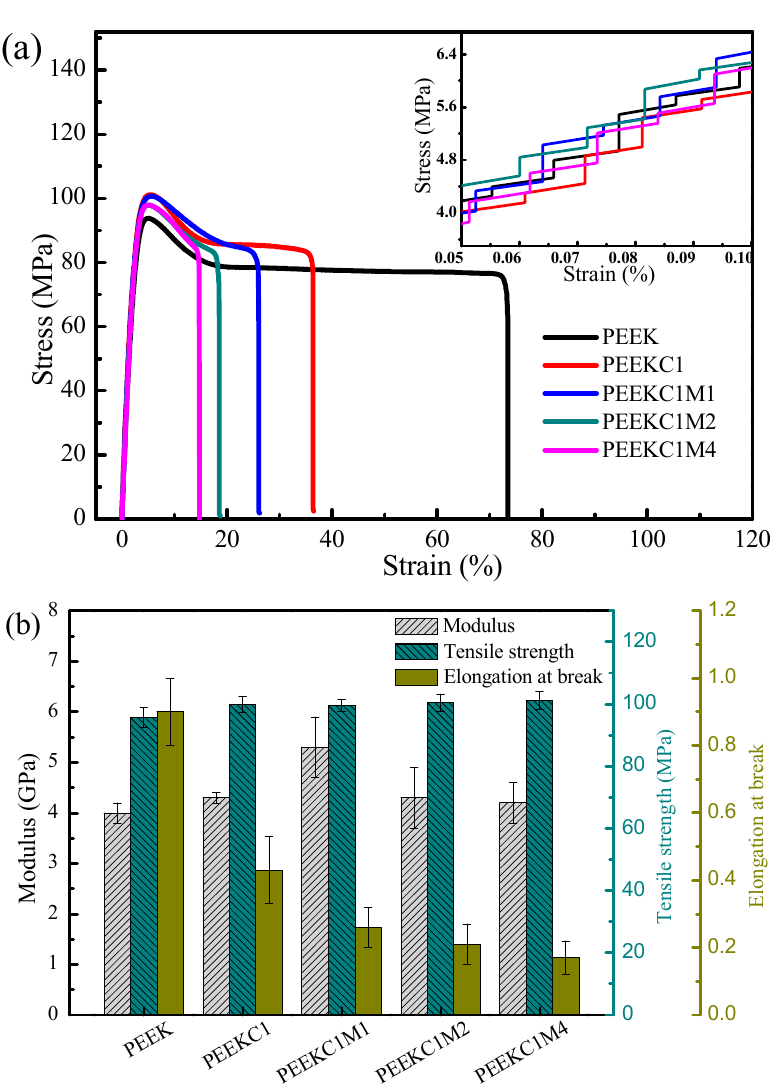
Figure 6. Typical engineering stress-strain curves of PEEK nanocomposites and the inset is the magnification of the linear region of the curve within which Young’s modulus is calculated ( a ), and the corresponding tensile properties ( b ).